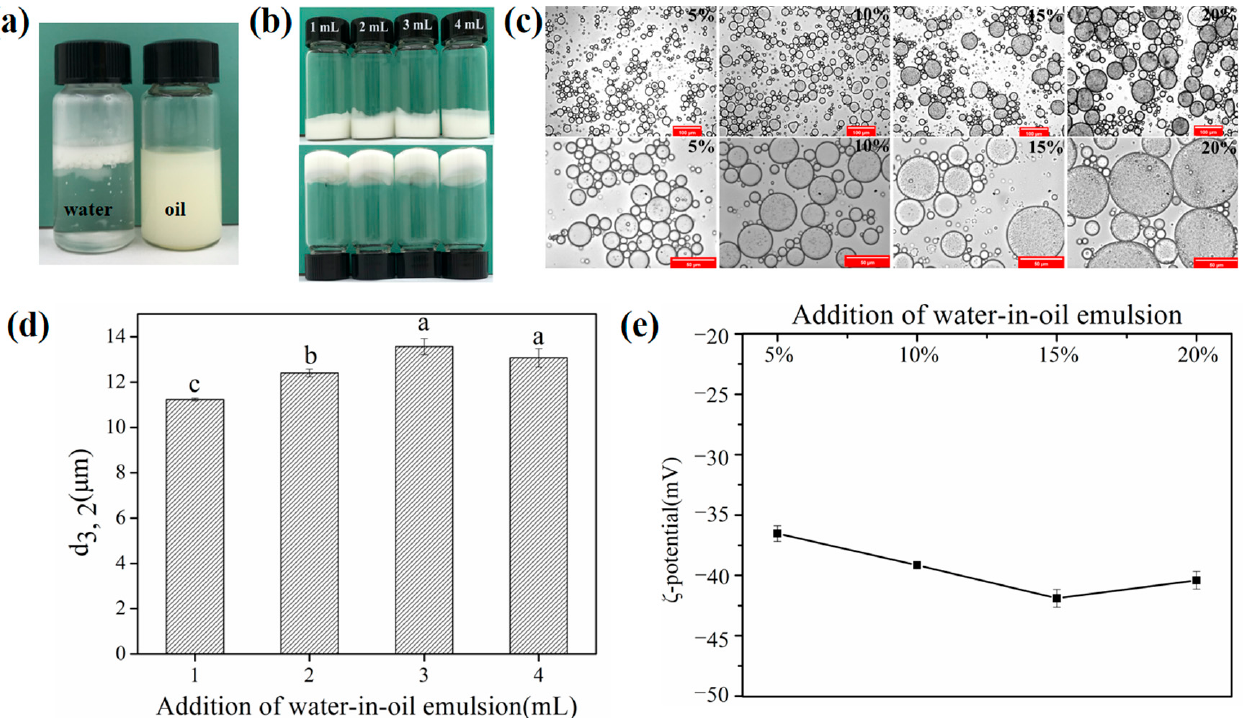
Figure 1. The type of primary emulsion (3.0% PGPR) ( a ); Visual appearance ( b ) and optical micro- graphs ( c ) of W 1 /O/W 2 emulgels (W 2 , 1.0 wt% SSPs) prepared by different additions of W 1 /O primary emulsion (5, 10, 15 and 20%). Scale bars, 100 µ m and 50 µ m, respectively. Droplet size (d 3, 2 ) ( d ) and ζ -potential ( e ) of W 1 /O/W 2 emulgels with different addition of W 1 /O primary emulsion. Different letters in sub-figure ( d ) means significance difference ( p <